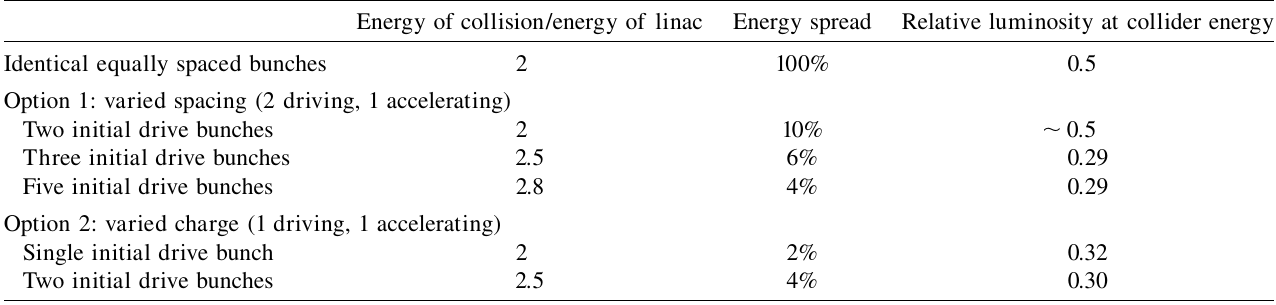
TABLE II. Energy of collision/energy of linac, energy spread, and luminosity at collider (relative to luminosity without the afterburner, assuming similar spot sizes and disruption). Last column assumes a 30 bunch train. Energy of collision/energy of linac Energy spread Relative luminosity at collider